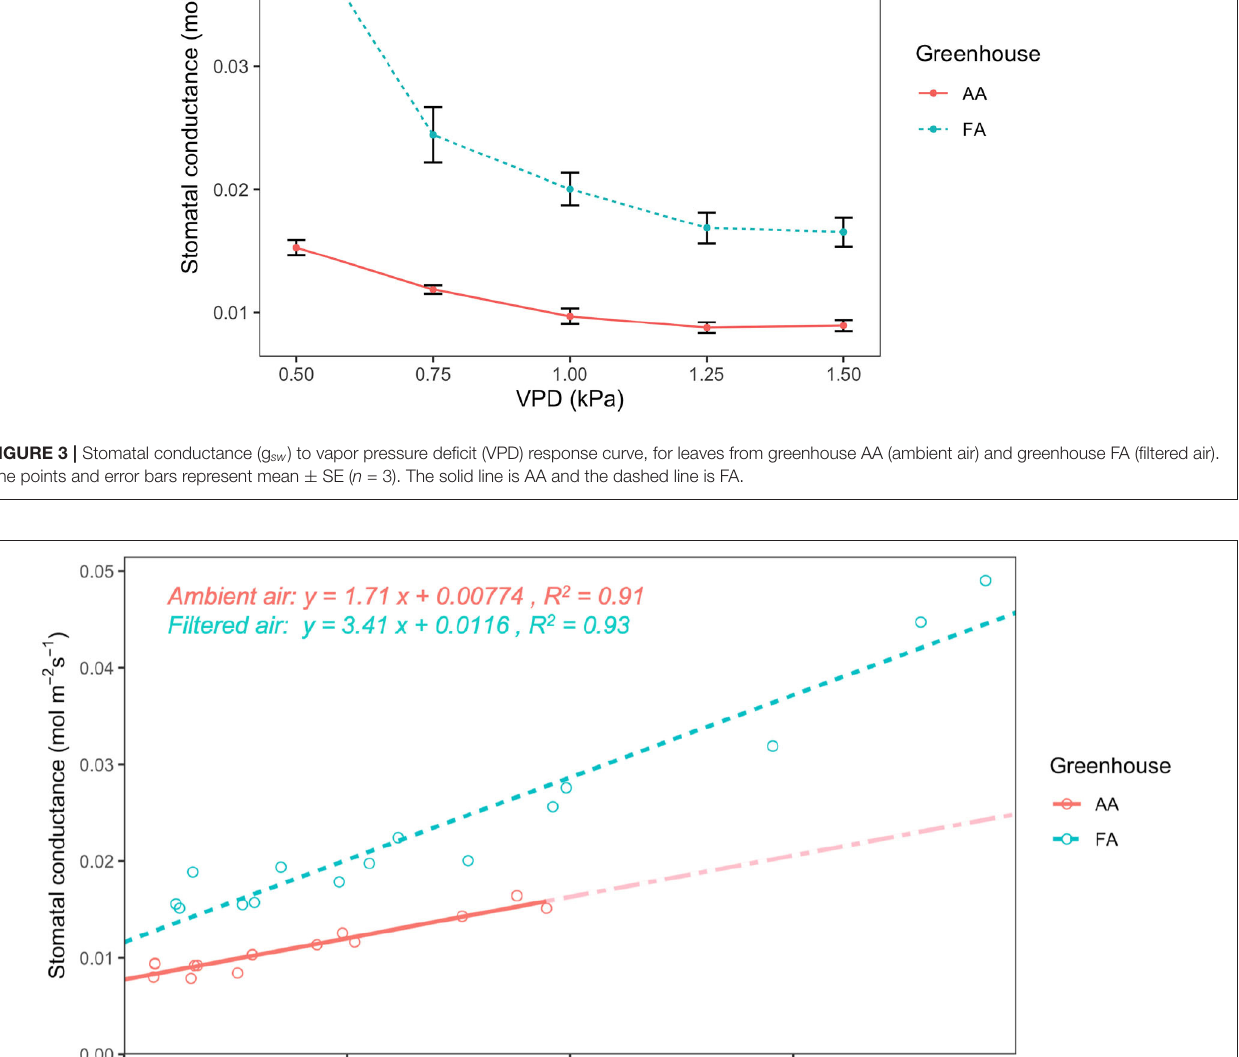
about half the slope for FA ( Figure 4 ), and the g sw intercept (g 0 ) of the linear regression for AA is also smaller than g 0 for FA ( P <